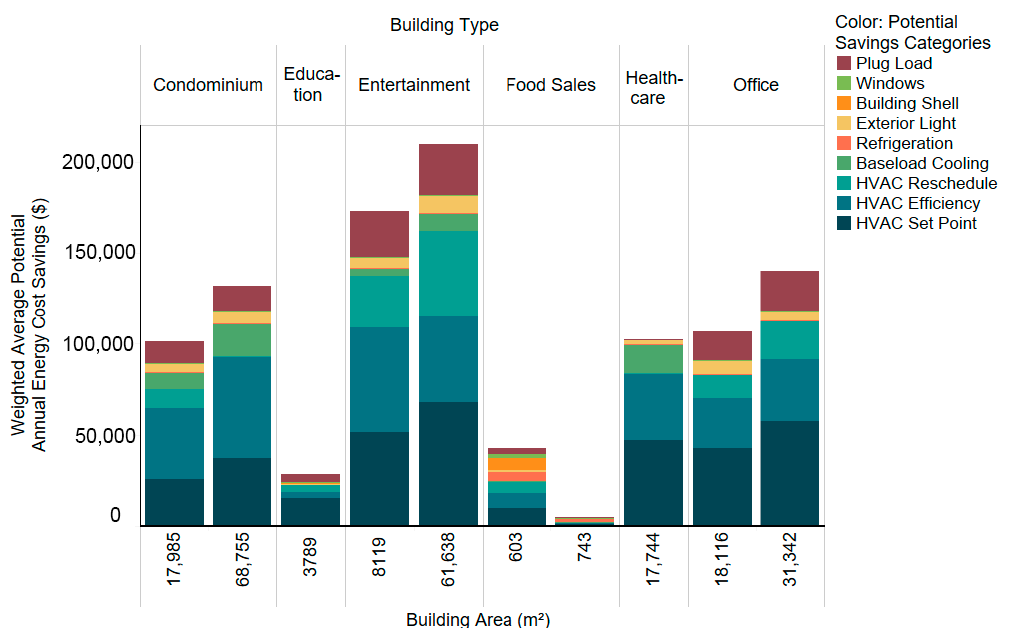
Figure 5. Estimated annual energy cost savings (USD) disaggregated by end-use/category vs. building area (m 2 ) and building type.